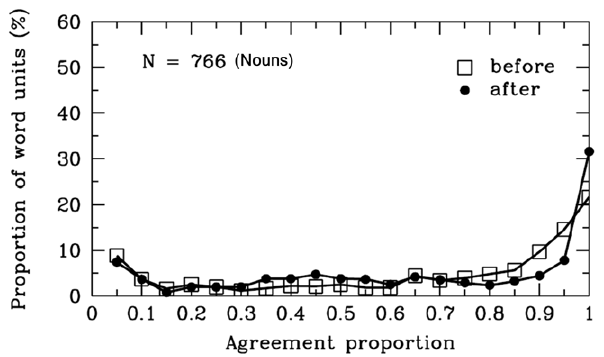
Figure 10. Nouns. Frequency distribution of agreement proportions for word boundaries before (open squares) and after (filled circles) the nouns units. The y-axis represents the proportion of SWU. The number of SWU is also represented in the figure.